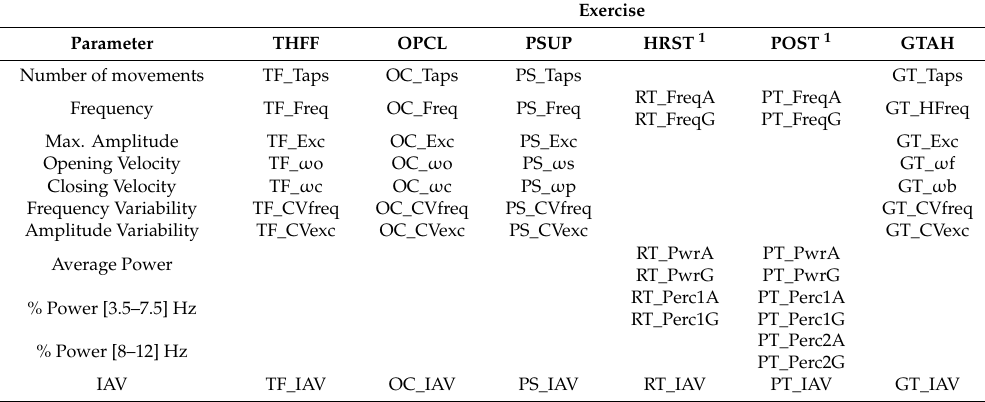
Table 2. List of parameters measured for each task (upper limbs) both for the right and left sides.